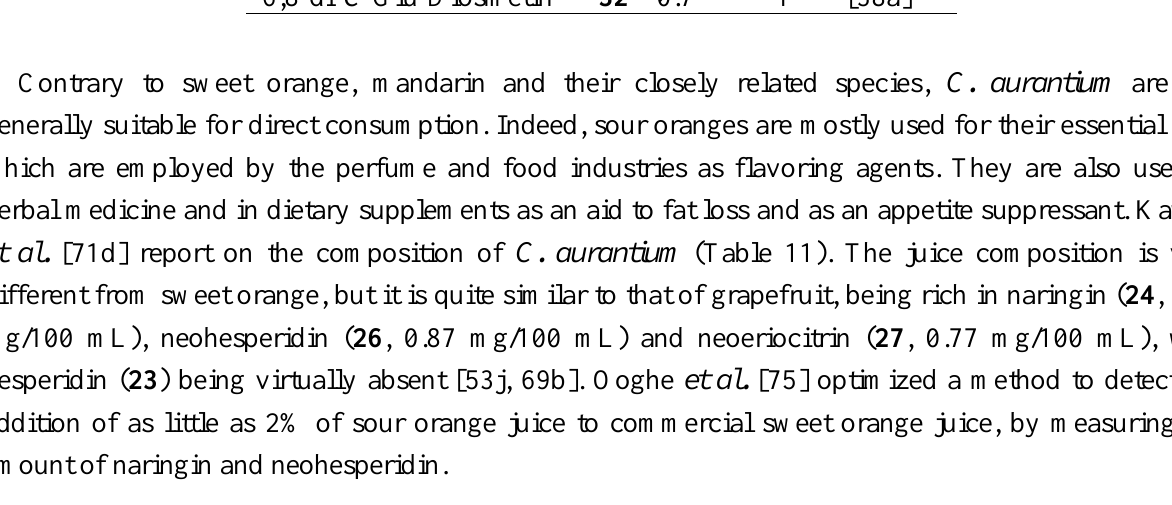
Table 11 . Flavonoid composition of C. aurantium juice (mg/100 mL).